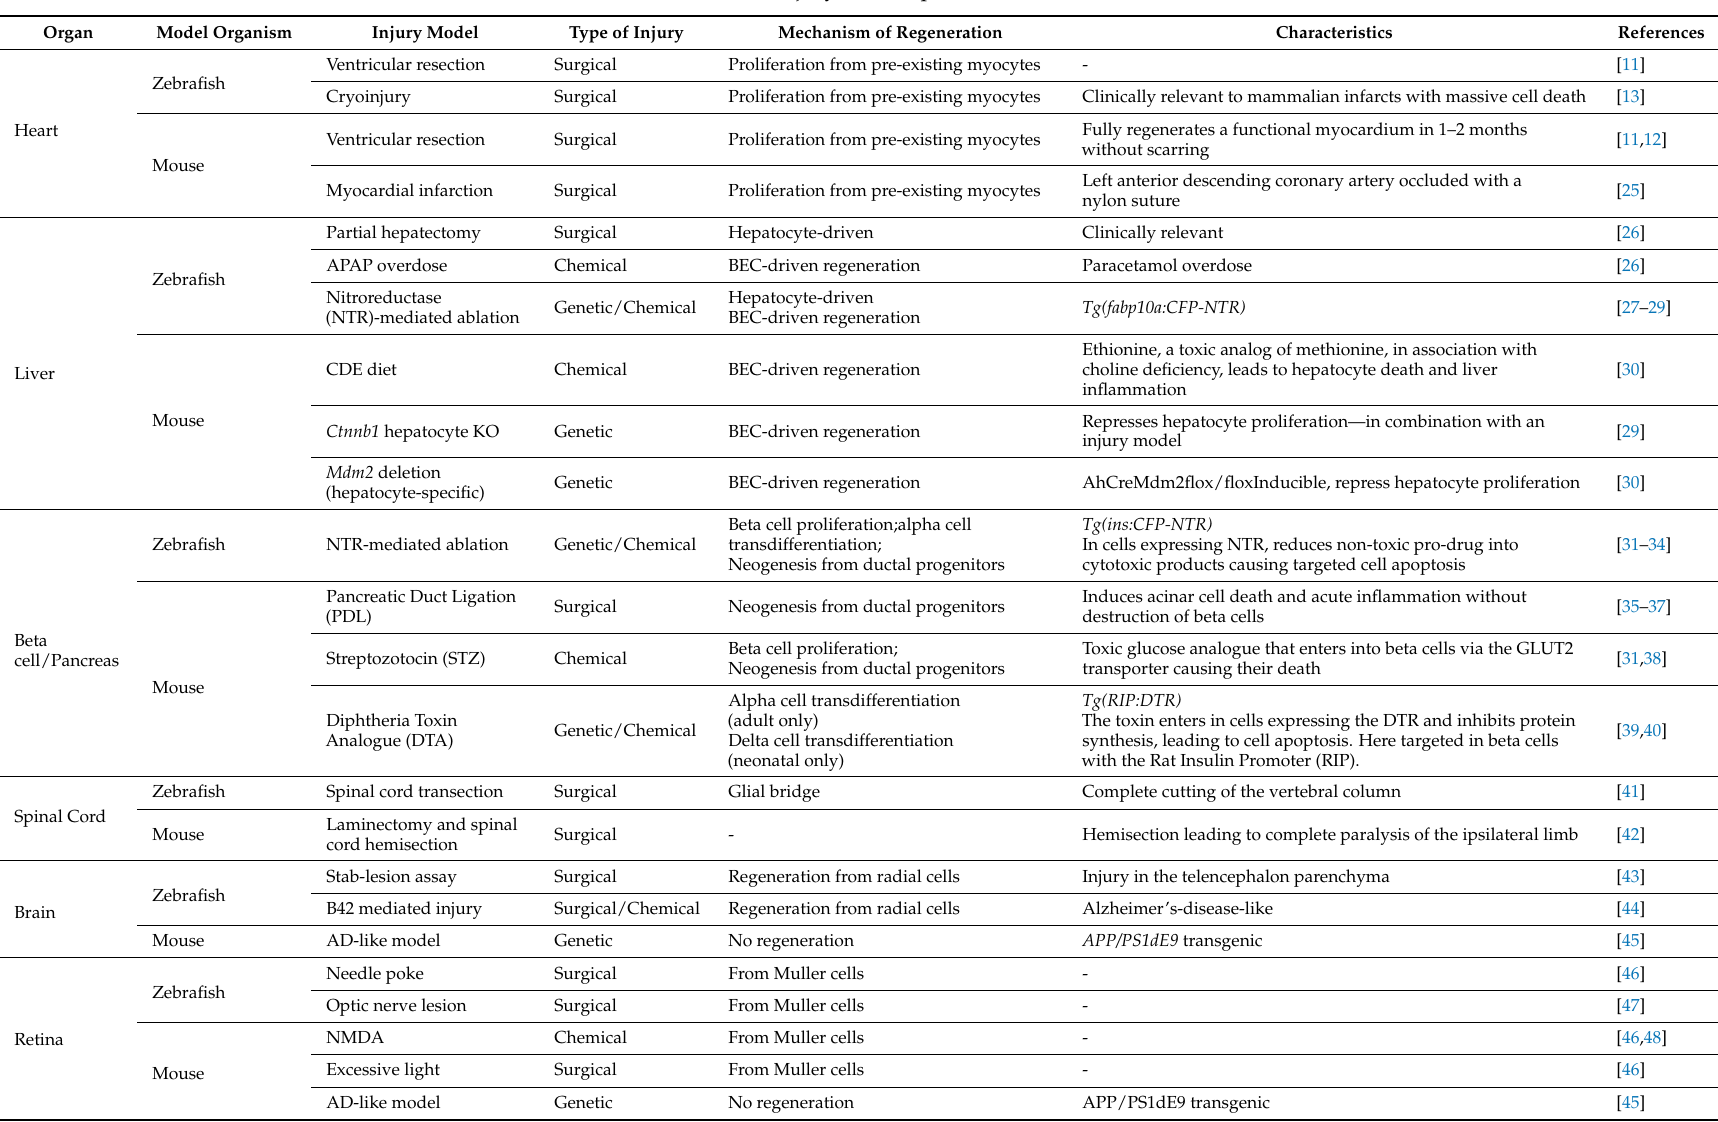
Table 1. Overview of injury models presented in the